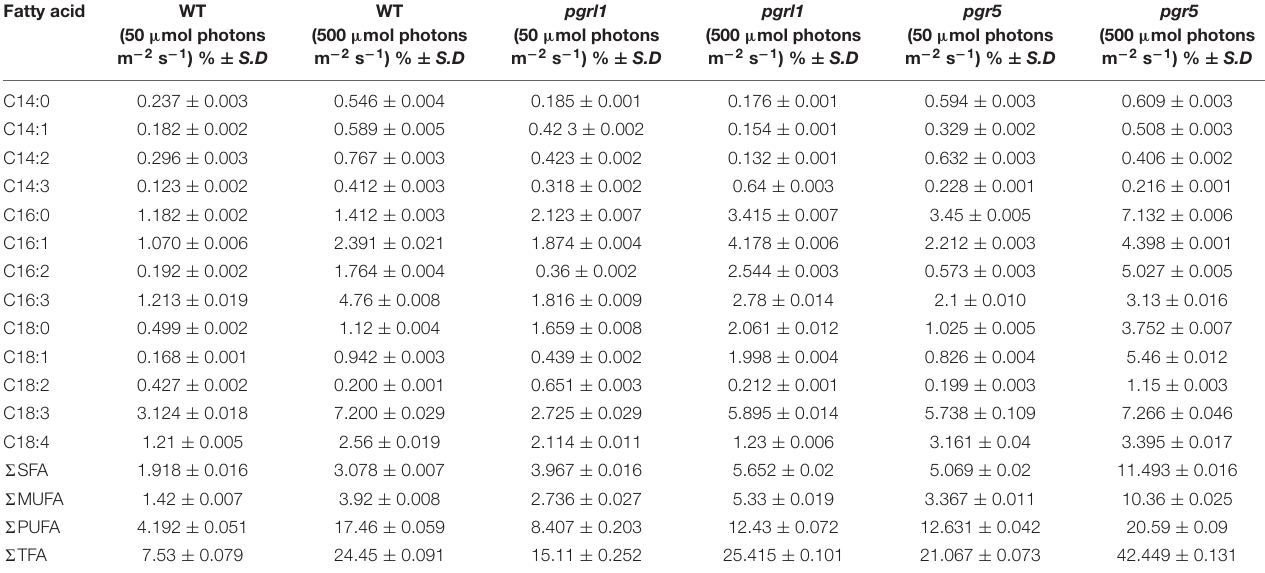
TABLE 1 | Fatty acid content of C.reinhardtii under normal and high light conditions. Fatty acid WT (50 µ mol